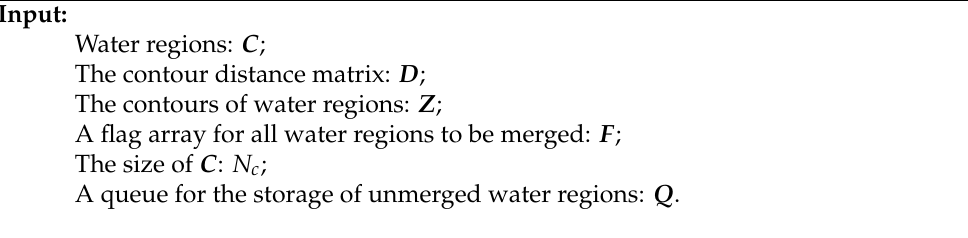
Algorithm 2 Multi-region merging